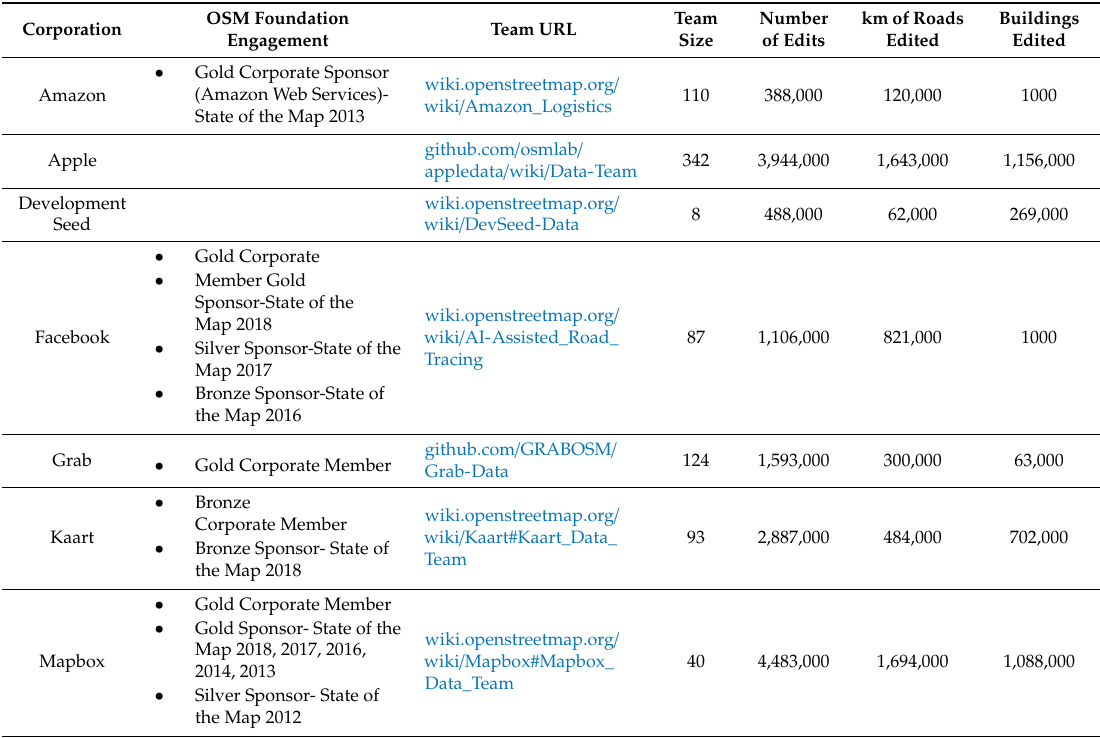
Table 1. Known Corporate editing teams active in OSM. The column OSM Foundation Engagements shows the current a ffi liation with OSM Foundation and their sponsorship of State of the Map conferences. Data for edits as of January 2019 (since 2014), rounded to the nearest